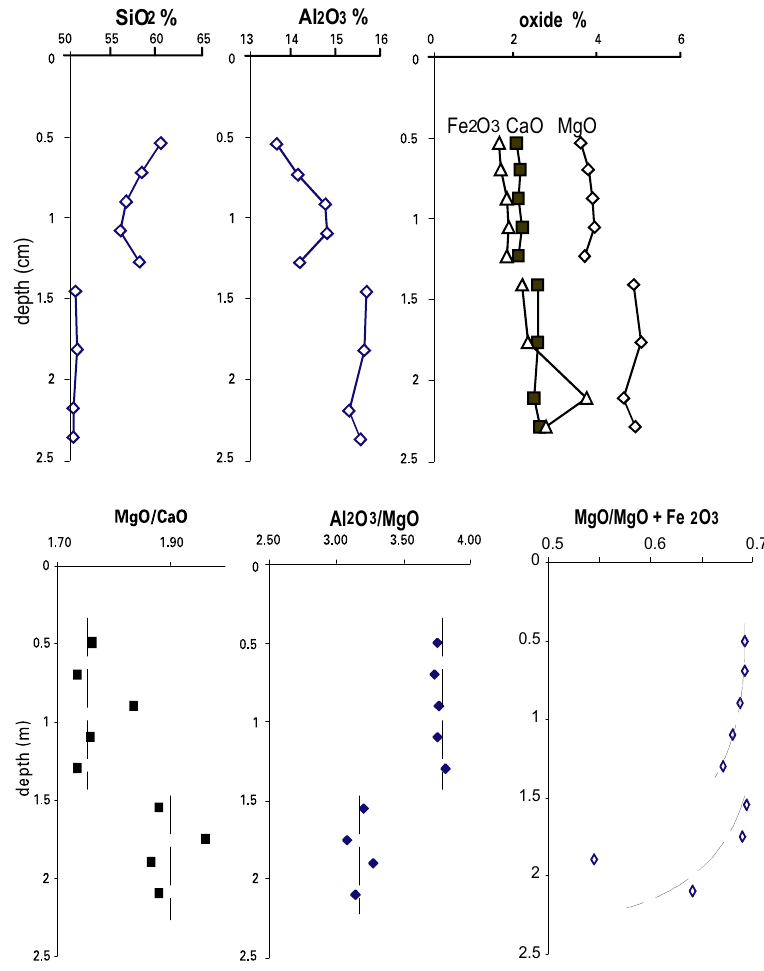
Fig. 3 – Evolution of the major chemical components throughout the profile. a) Variation of absolute values vs depth (m). b) Variation of MgO/CaO, Al 2 O 3 /MgO and MgO/MgO + Fe 2 O 3 ratios vs depth